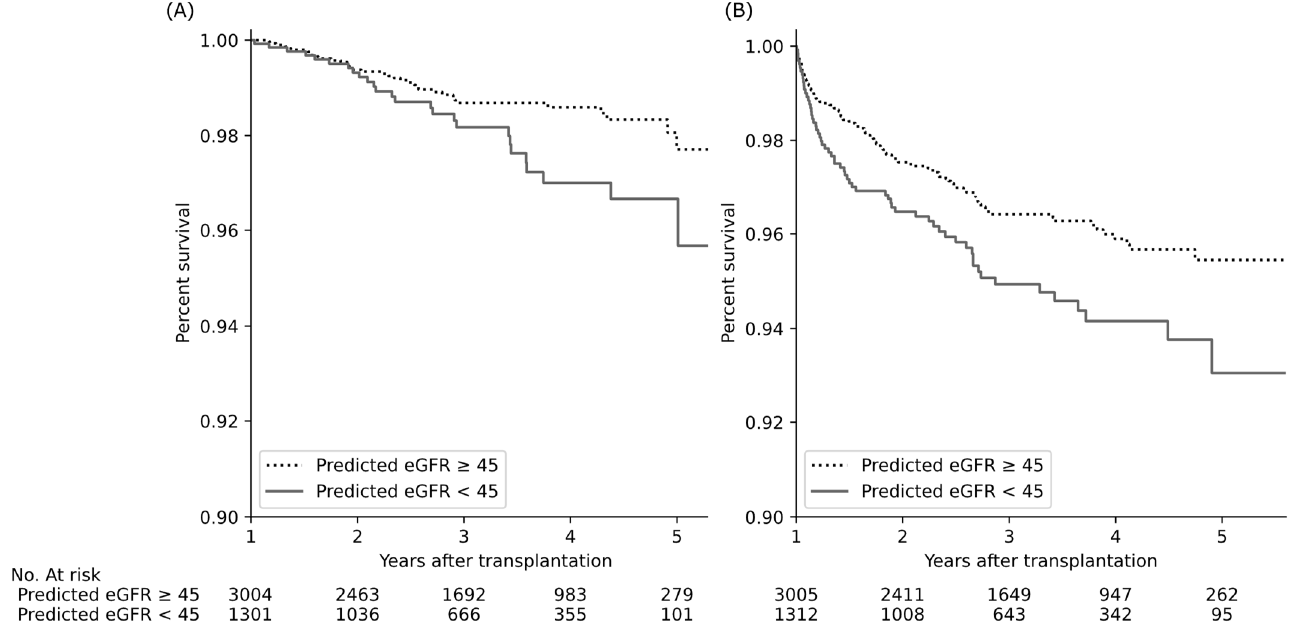
Figure 3. Kidney transplant outcomes according to predicted one-year eGFR levels of the recipient. Predicted eGFR decline was associated with a significant decrease in graft survival ( A ) and increase in cumulative incidence of biopsy-proven rejection ( B ) (adjusted hazard ratios of 1.9 and 1.6, p = 0.02 and p = 0.007, respectively, Cox proportional hazard regression with age and sex). Abbreviations: eGFR, estimated glomerular filtration rate (mL/min/1.73 m 2 ).